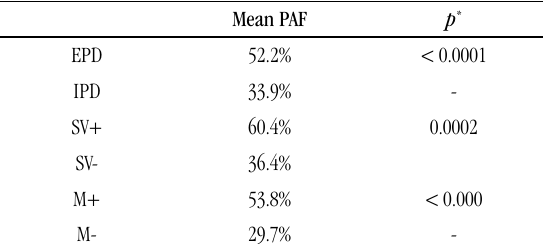
tABLE 2 – Assessment of mean percentage of affected fragments and pathological findings in the surgical specimen